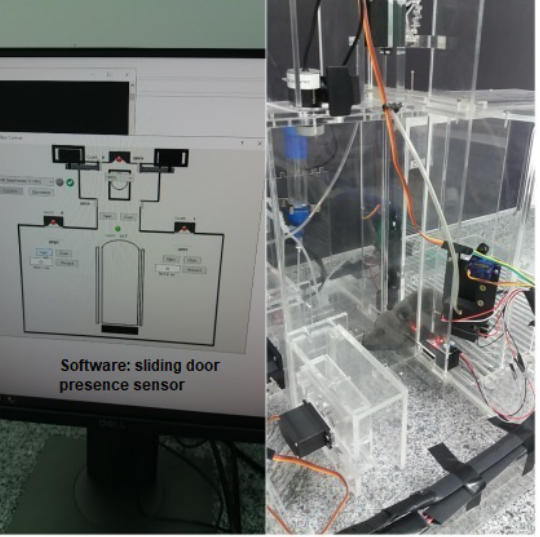
Figure 22. Remote control mouse in behavior box: activating the central sensor, for mouse safety, preventing crushing.